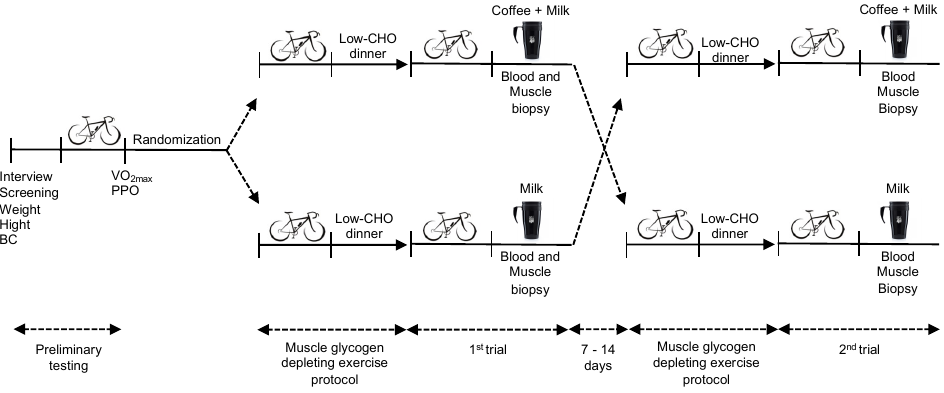
Figure 1. Overview of the experimental trial. BC: body composition; CHO: carbohydrates; PPO: peak power output; VO 2max : maximal oxygen uptake.